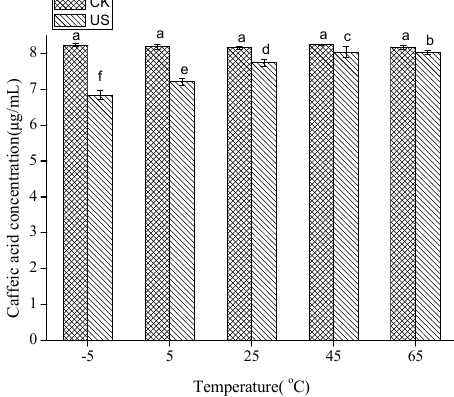
Different letters on bars indicate significant differences ( p <